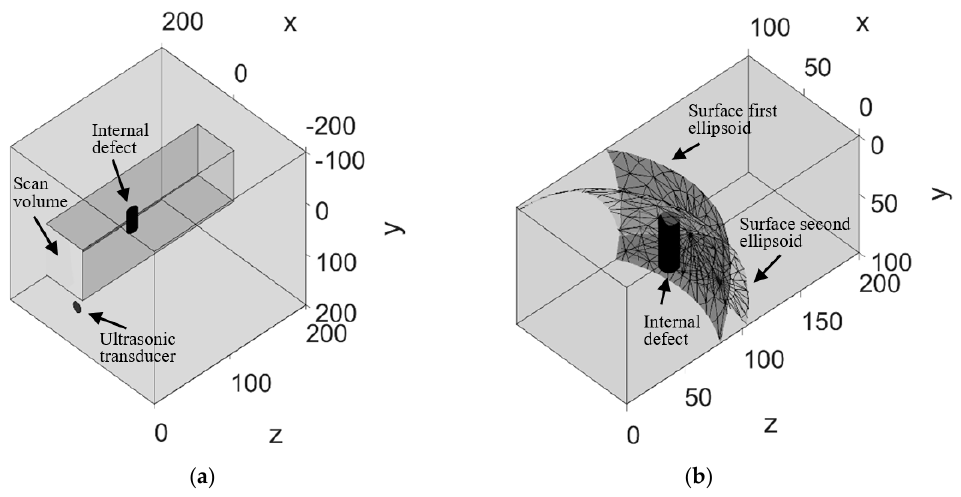
Figure 6. Resulting ellipsoid intersections from two-second echo TOFs estimated during the proposed analysis of two laser-generated ultrasonic waves experimentally measured. ( a ) Isometric view of the scan volume allocation. ( b ) Details of the scan volume and the intersection of two resulting ellipsoids and its coherence with regard to the defect position. The first ellipsoid results from the ultrasonic transducer’s position, scan point 1 position, and TOF 17.4 mm. The second ellipsoid results from the ultrasonic transducer’s position scan point 2 position, and TOF 18.6 mm.